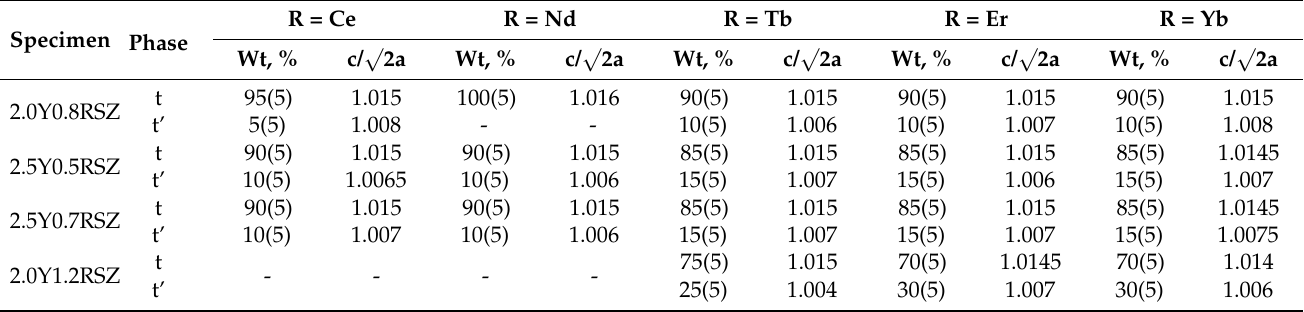
Table 1. Phase composition and tetragonality degree of crystals.